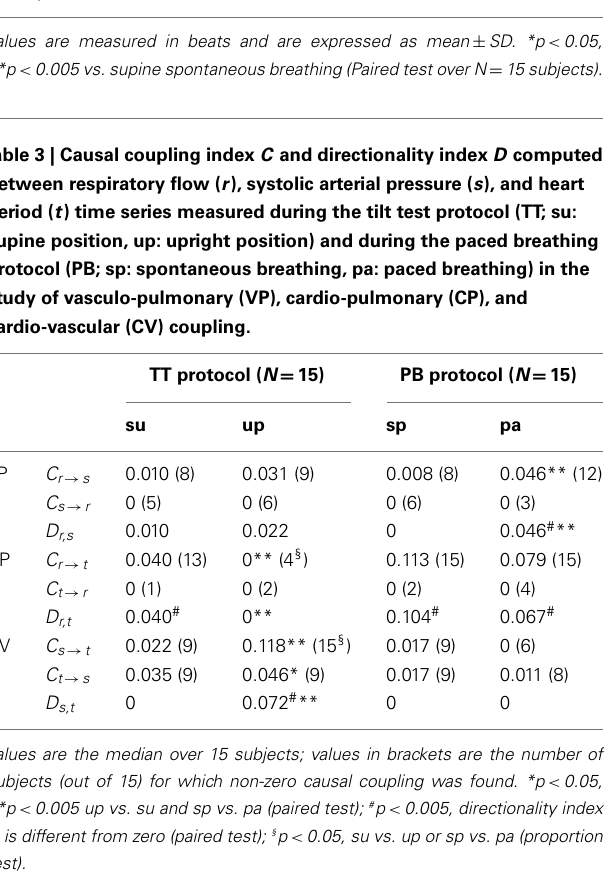
Figure 1C : up, sp; Figure 1D : su, pa). The trends of the time